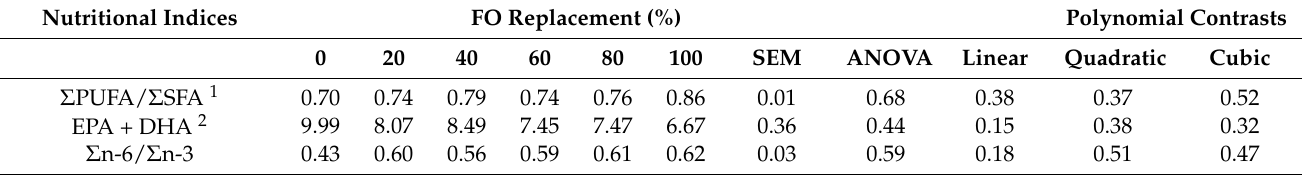
Table 8. Nutritional indices of the whole-body of juvenile tench fed experimental diets with different levels re-placement of cod liver oil (FO) by a blend of vegetable after 90